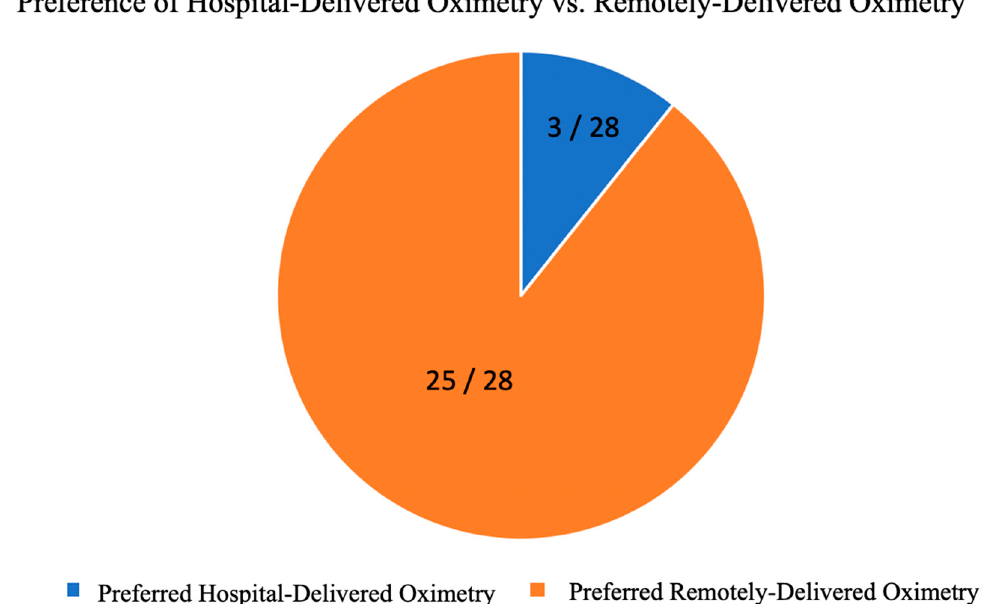
Figure 4. Preference for hospital-delivered oximetry (HDO) vs. remotely delivered oximetry (RDO). The graph shows that 3 out of 28 patients preferred the HDO and 25 out of 28 preferred the RDO.